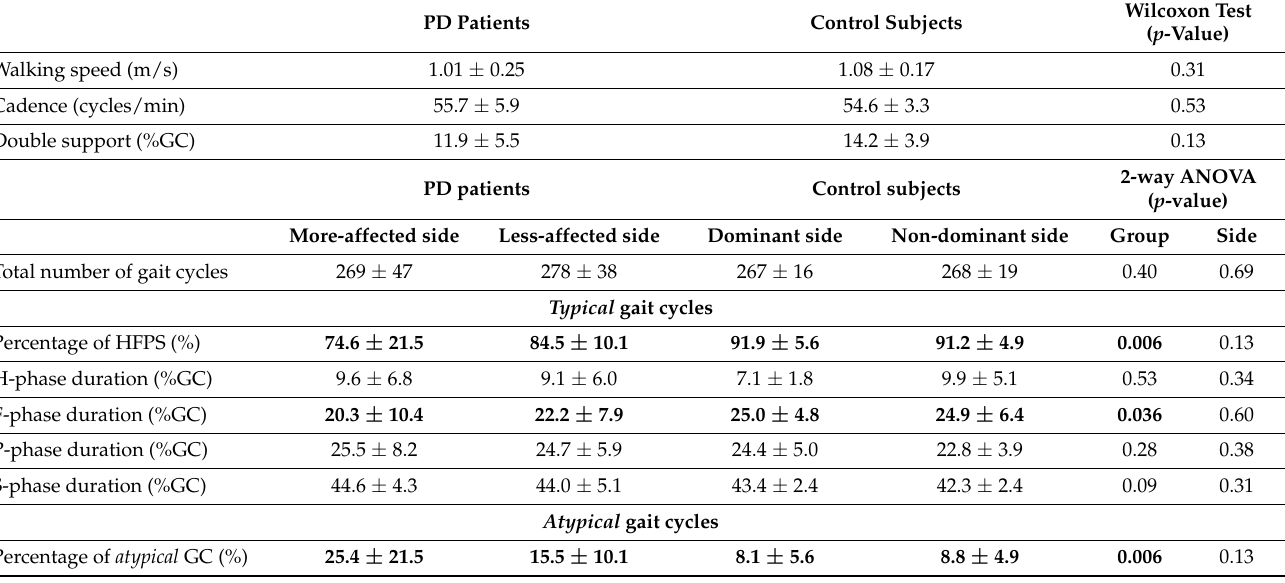
Table 1. Gait analysis parameters averaged over Parkinson’s Disease (PD) patients and control subjects.